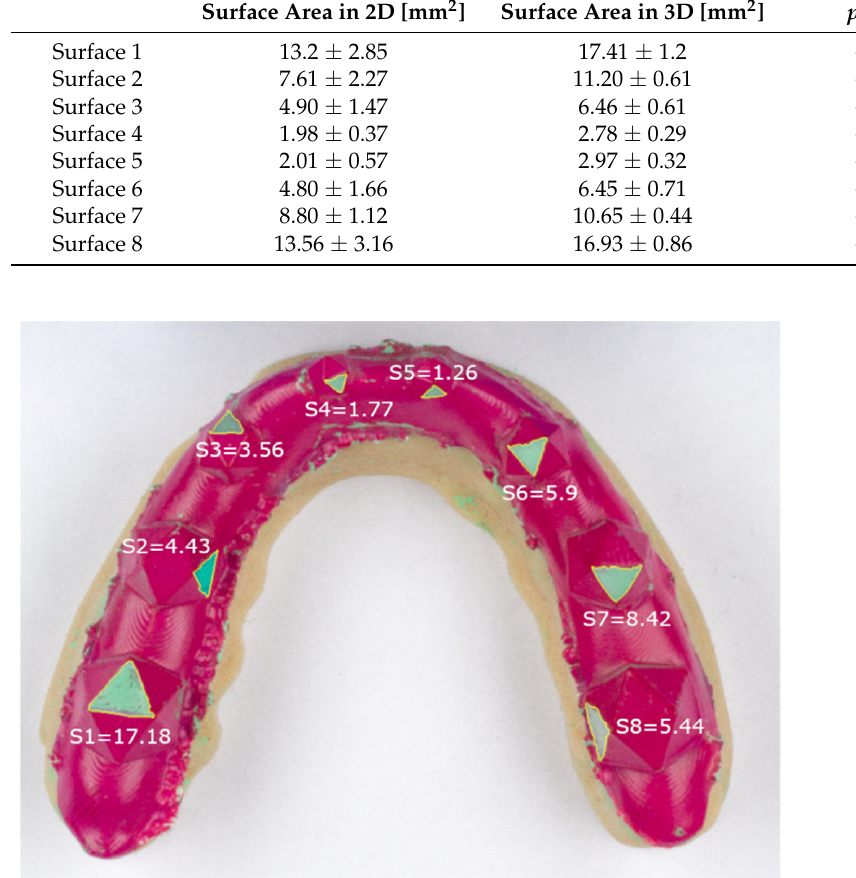
Figure 5. Example of a 2D measurement (Splint 2 shown). Surface area for each grinding surface is reported in mm 2 . While measurements on the same size icosahedrons should be relatively close, stark differences can be seen, e.g., between S1 and S8.